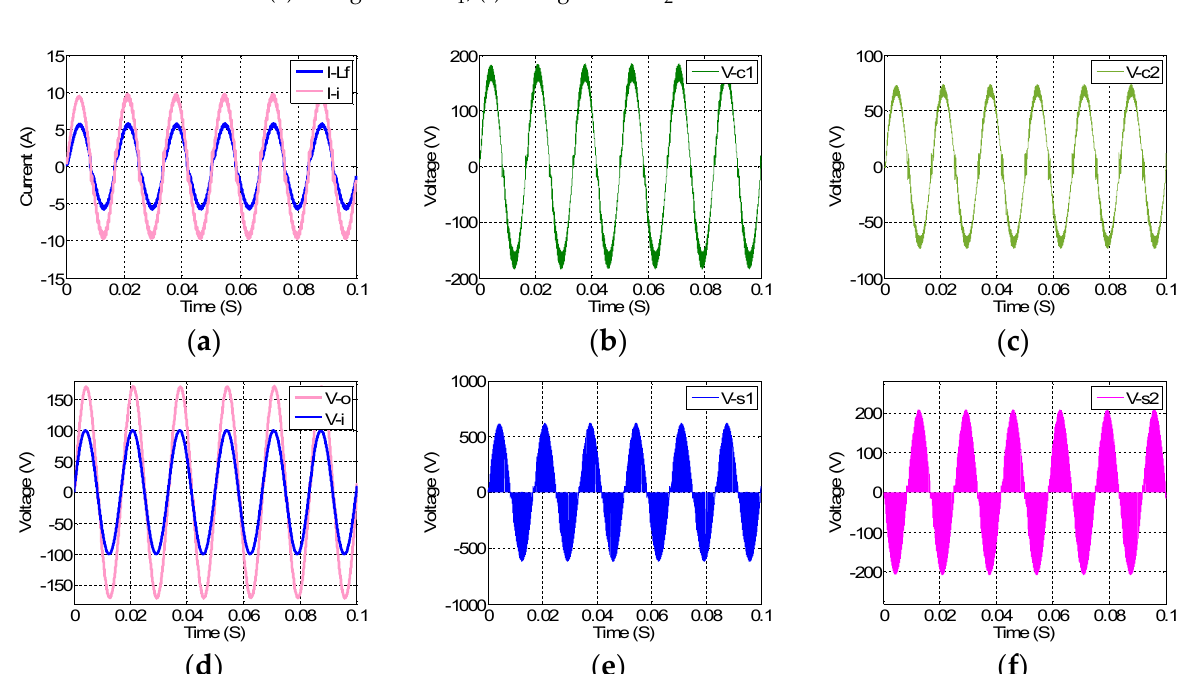
Figure 13. Simulation results of the proposed converter in boost in-phase mode with n = 1.5, R = 30 Ω, and D = 0.12. ( a ) output filter and input current; ( b ) Voltage across C 1 ; ( c ) voltage across C 2 ; ( d ) output and input voltages; ( e ) voltage across S 1 ; ( f ) voltage across S 2.